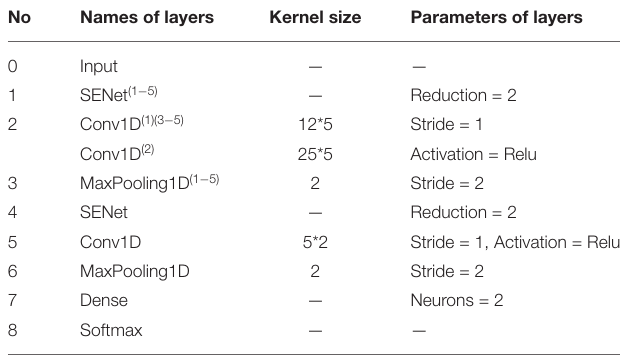
The ** represents the level of the convolution filter: SENet (1 − 5) represents the SENet of the 1 st to 5 th layers.